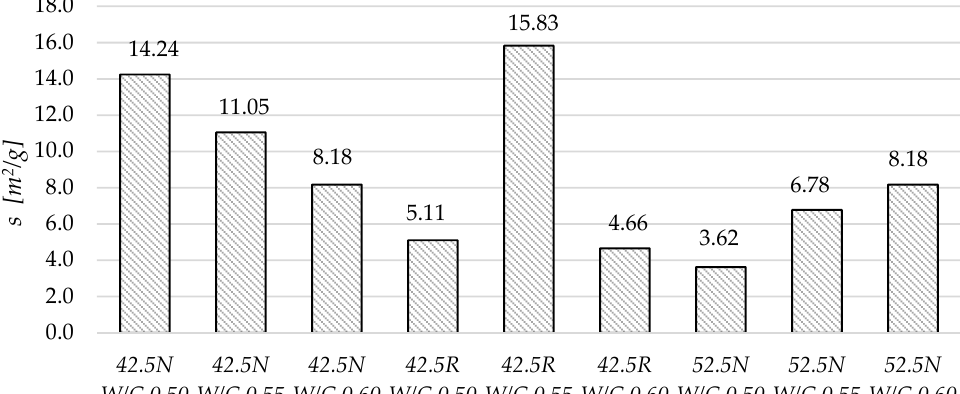
Figure 11. Total porosity of the tested mortars determined using mercury intrusion porosimetry.